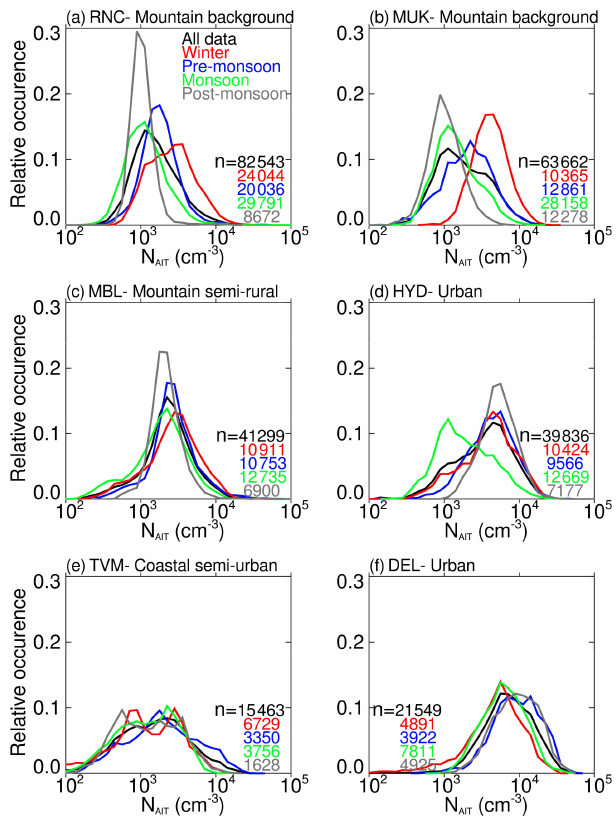
Figure 6. Histogram of the relative occurrence of Aitken mode par- ticle number concentrations at the sites. The concentration bins are logarithmically spaced on the x axis, and the y axis shows the rela- tive occurrence of values in each bin compared to the total num- ber of valid observations. The black, blue, red, green, and gray lines indicate all data, winter (DJF), pre-monsoon (MAM), mon- soon (JJAS), and post-monsoon (ON), respectively. n indicates the number of 10min averaged valid data points. Note that measure- ments are from different time periods for each site (see Table